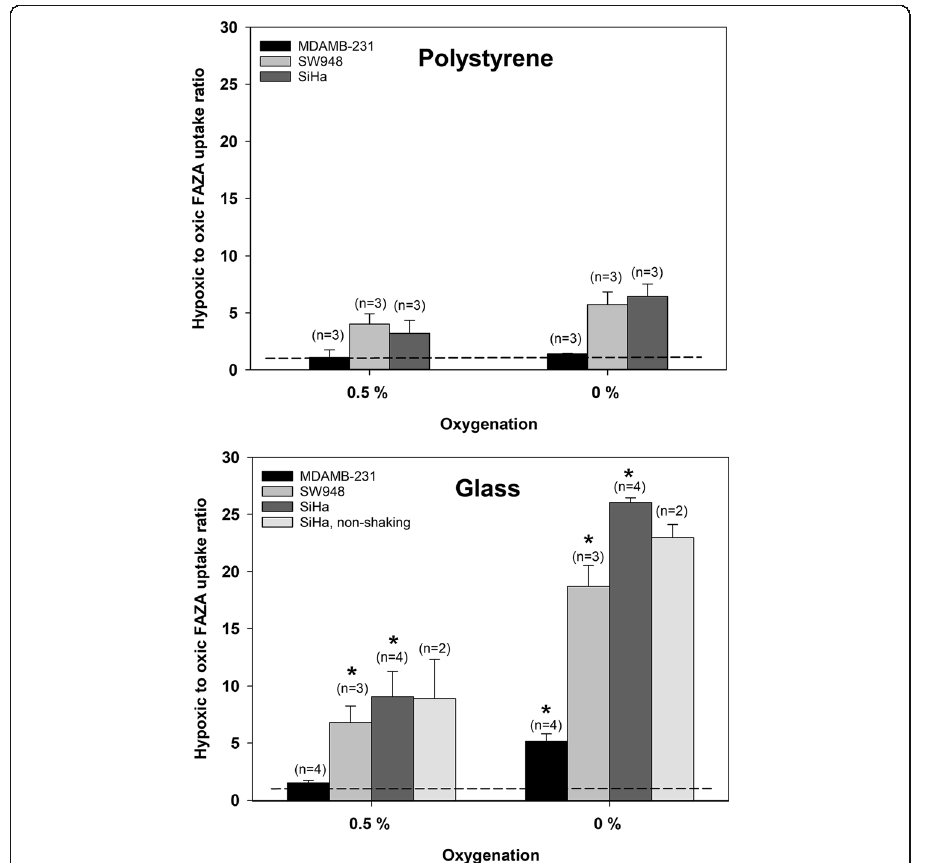
uptake under hypoxic (0.5% O 2 ) and anoxic (0% O 2 ) gas equilibration is expressed relative to the radioactivity measured in well-oxygenated (21% O 2 ) cells. The dotted line represents a ratio of 1, that is, no stimulation of uptake. Values are means (± SEM). The number of independent experiments for each condition is given in parentheses. The asterisks denotes a significant difference between glass and polystyrene at a given oxygenation level ( p <